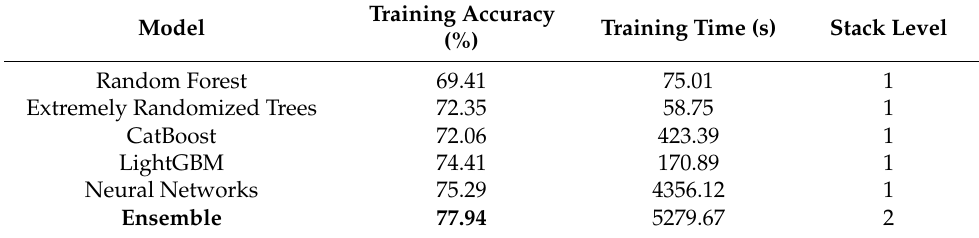
Table 5. Level II accuracy comparison of different models of EULUC-seg in terms of training accuracy, training time, and stack level. Note the training accuracy is the average overall accuracy of the 5-fold cross-validation during